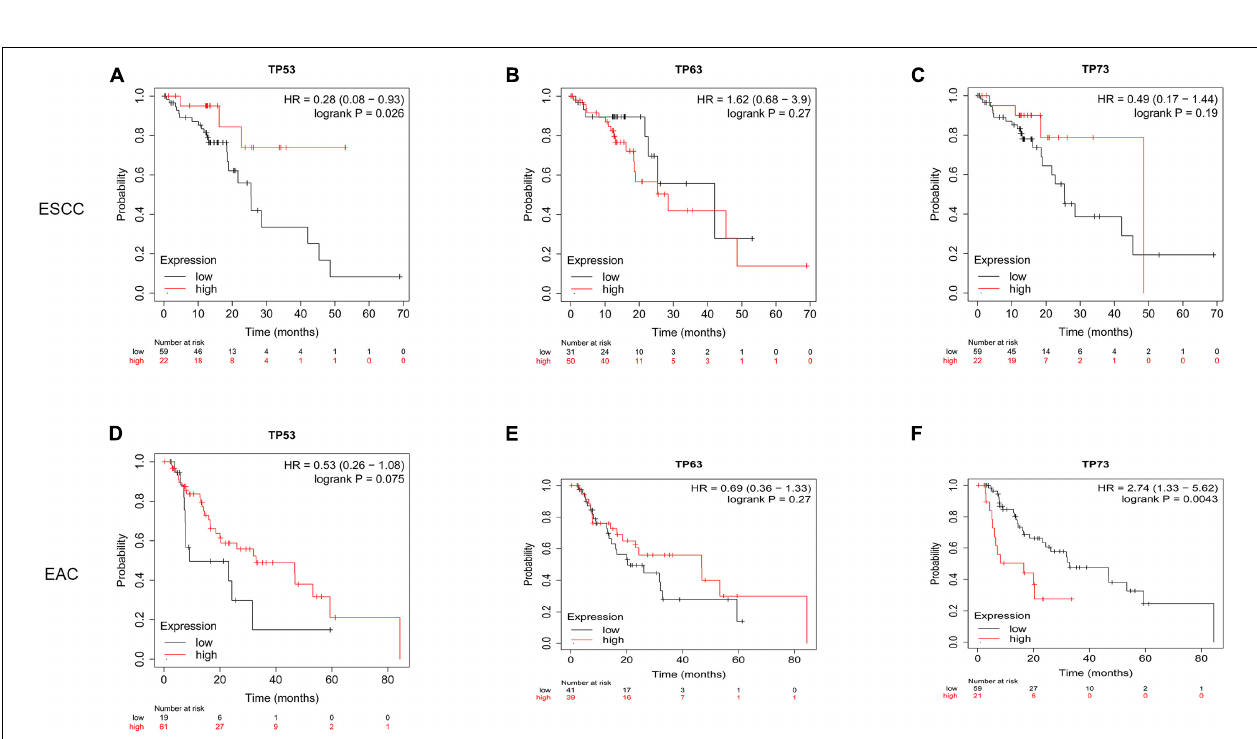
FIGURE 4 | Prognostic value of TP53 family members in ESCA patients. Overall survival curves for TP53 family members in ESCA patients (A–F) .